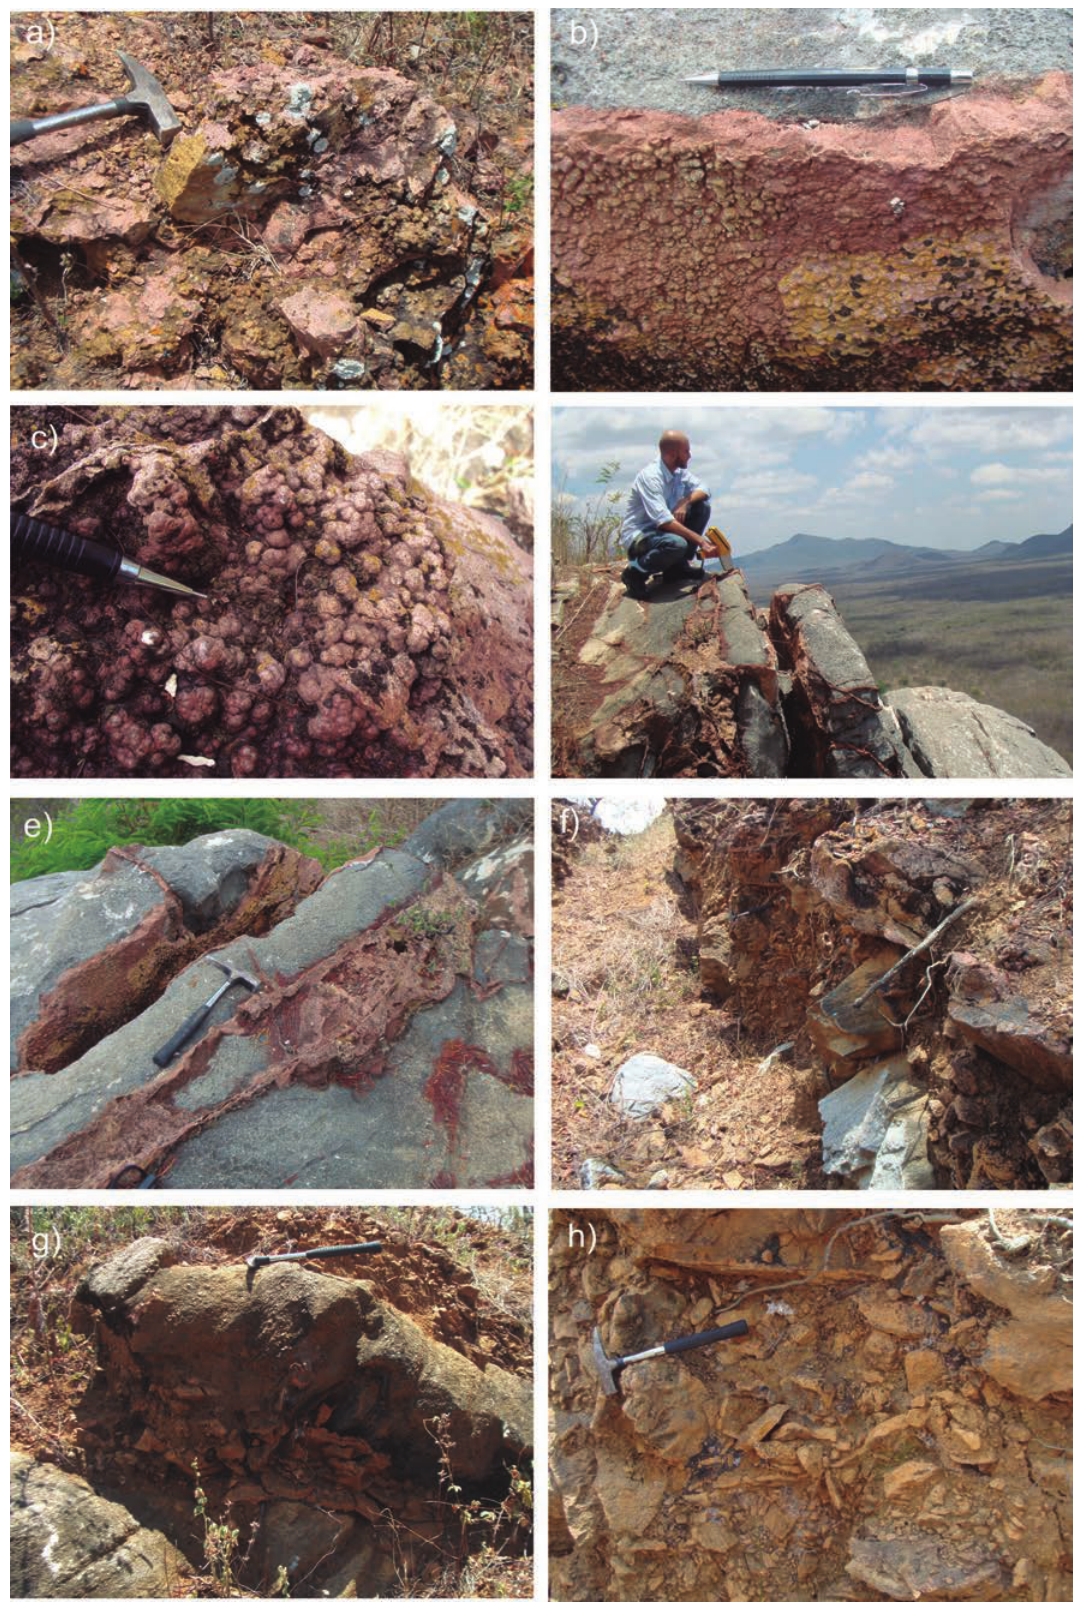
Figure 11 - The main features of karstic collophanites: a) massive collophanite on the top of main ore body; b) collophanites with botryoidal textures; c) detail of collophanites with botryoidal texture; d) collophanite filling open fractures in marble; e) detail of open fractures filling with collophanites; f) and g) collophanites fragments filling karstic features; h) detail of collophanites fragments filling karstic